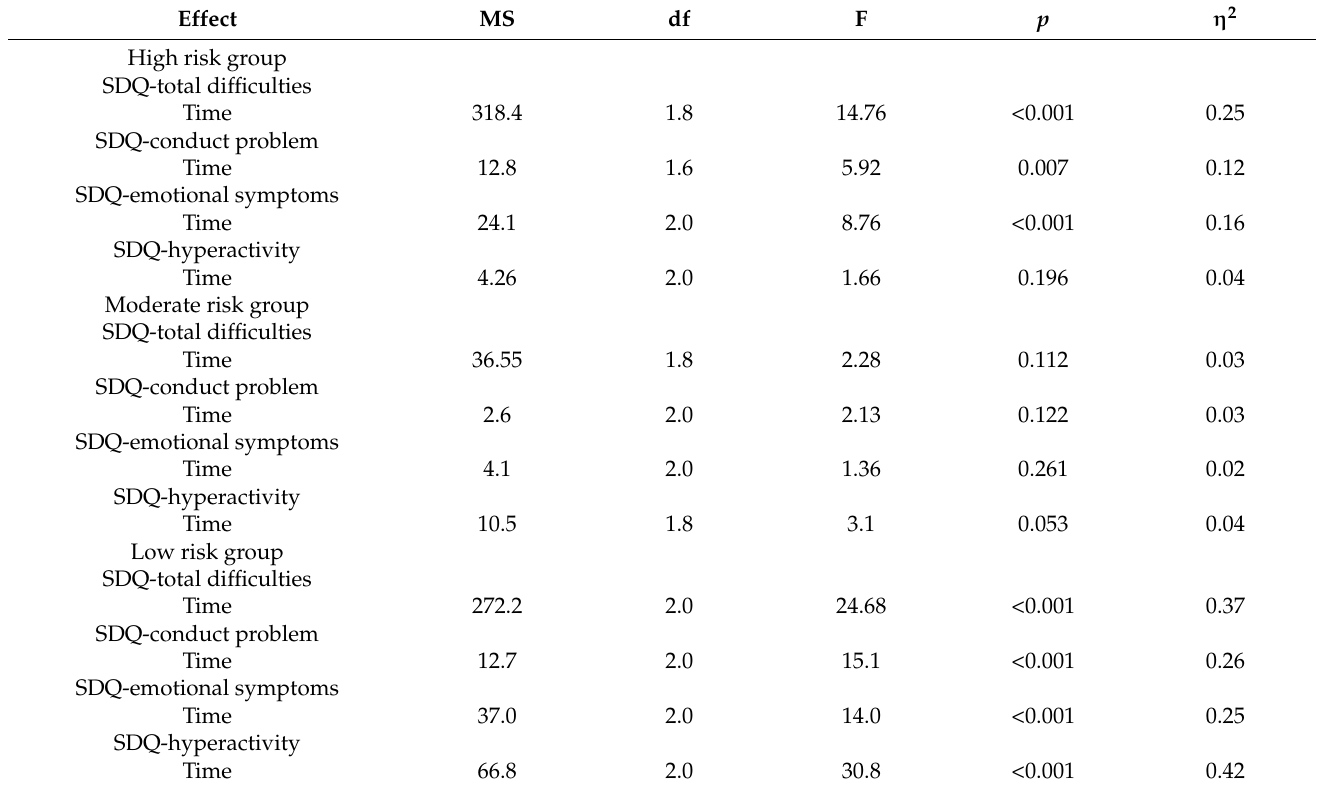
Table 5. One-way repeated measures ANOVA of SDQ components in three risk